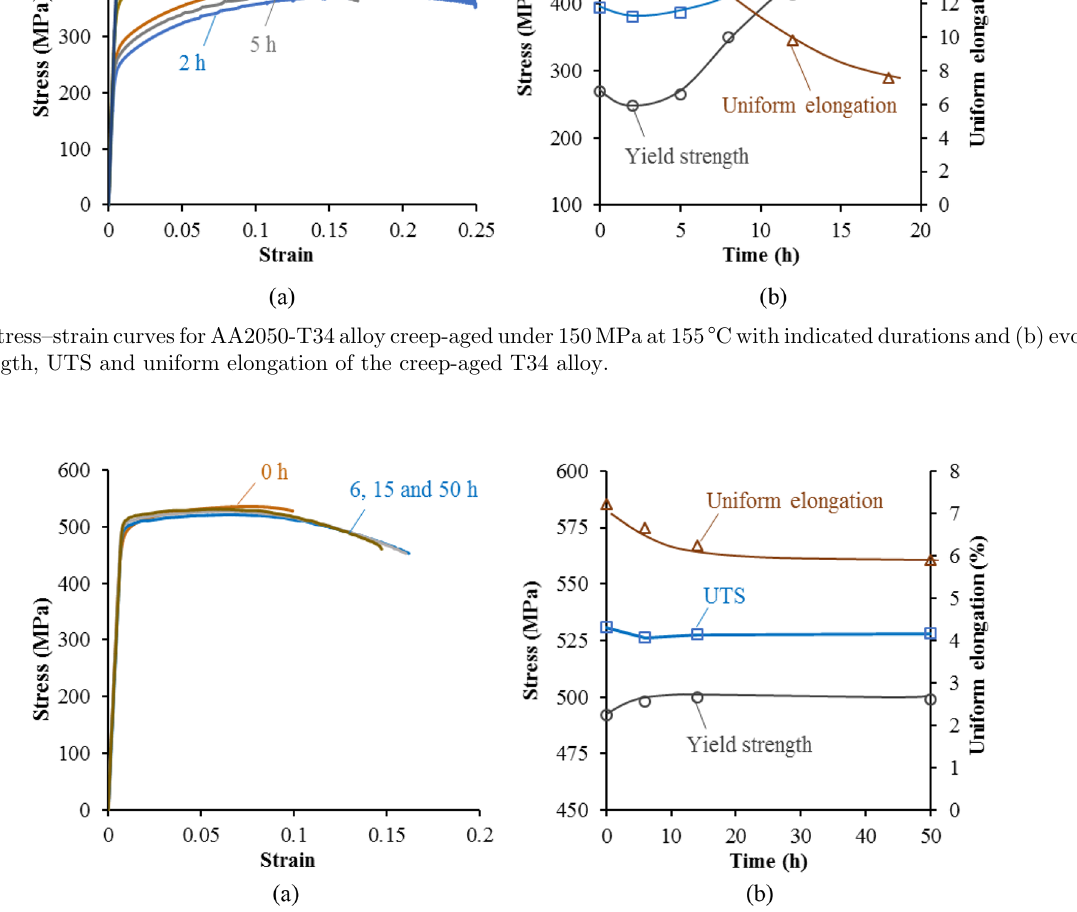
Fig. 6. (a) Tensile curves of AA2050-T84 alloy creep-aged under 150 MPa at 155 ° C for different durations and (b) evolutions of yield strength, UTS and uniform elongation of the creep-aged T84 alloy.